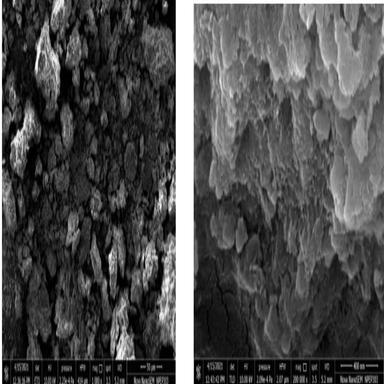
SEM analysis of 1 % nano mixed -PCM.